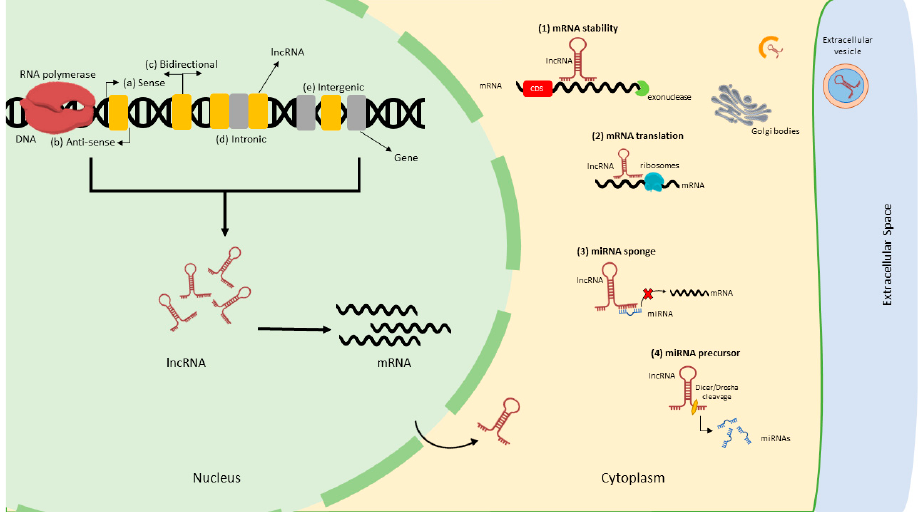
Figure 2. Biogenesis, classification, and mechanism of gene regulation by lncRNAs. LncRNA is transcribed by RNA polymerase, which can be categorized into several types: (a) sense; (b) antisense; (c) bidirectional; (d) intronic, and (e) intergenic [37]. The mechanism of gene regulation of lncRNAs is presented: (1) mRNA stability (via recruitment or impairment of RNA degrading enzymes such as exonucleases) [38], (2) mRNA translation (via recruitment or impairment of ribosomes) [39], (3) miRNA sponge (lncRNAs can prevent miRNA by targeting mRNAs by acting as competing endogenous RNAs (ceRNAs) [31], and (4) miRNA precursors (lncRNAs harbor miRNAs by acting as precursors)